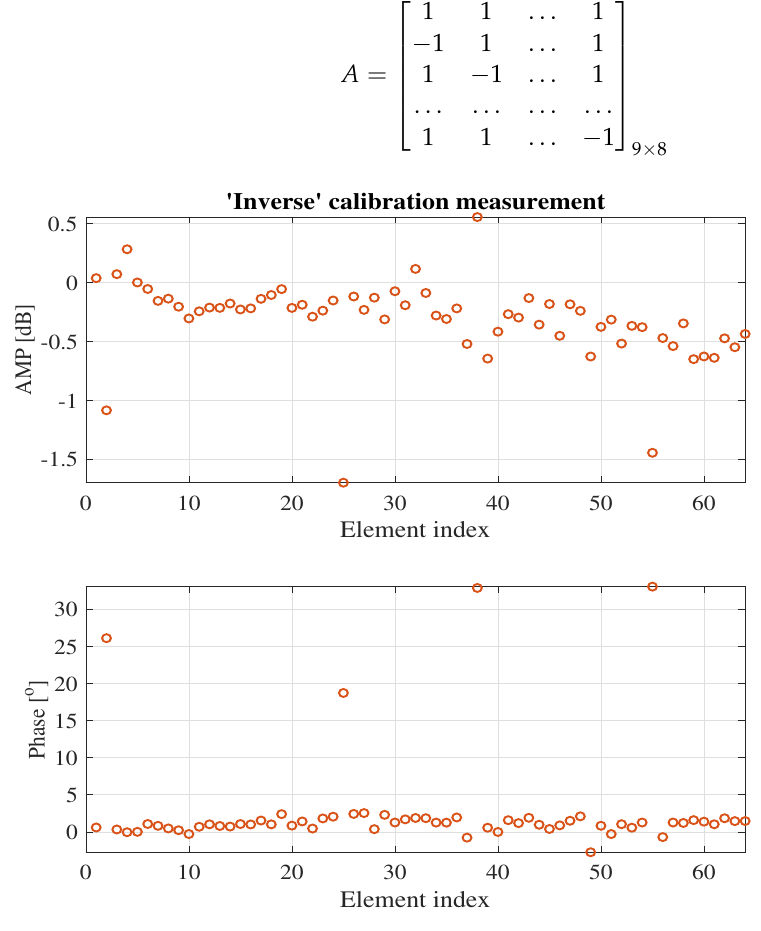
Figure 9. ‘Inverse’ calibration effectiveness measurement